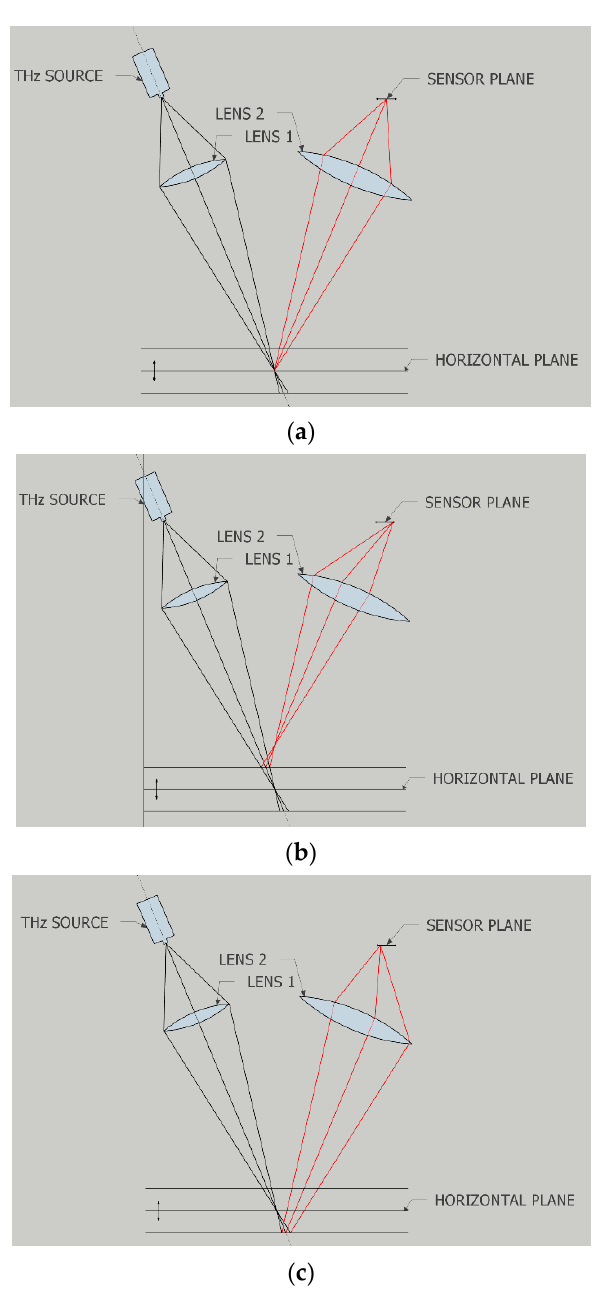
Figure 1. The proposed layout of the measurement setup: ( a ) THz signal propagation when the hor- izontal plane is in the middle position; ( b ) THz signal propagation when the horizontal plane is raised vertically; ( c ) THz signal propagation when the horizontal plane is lowered vertically.